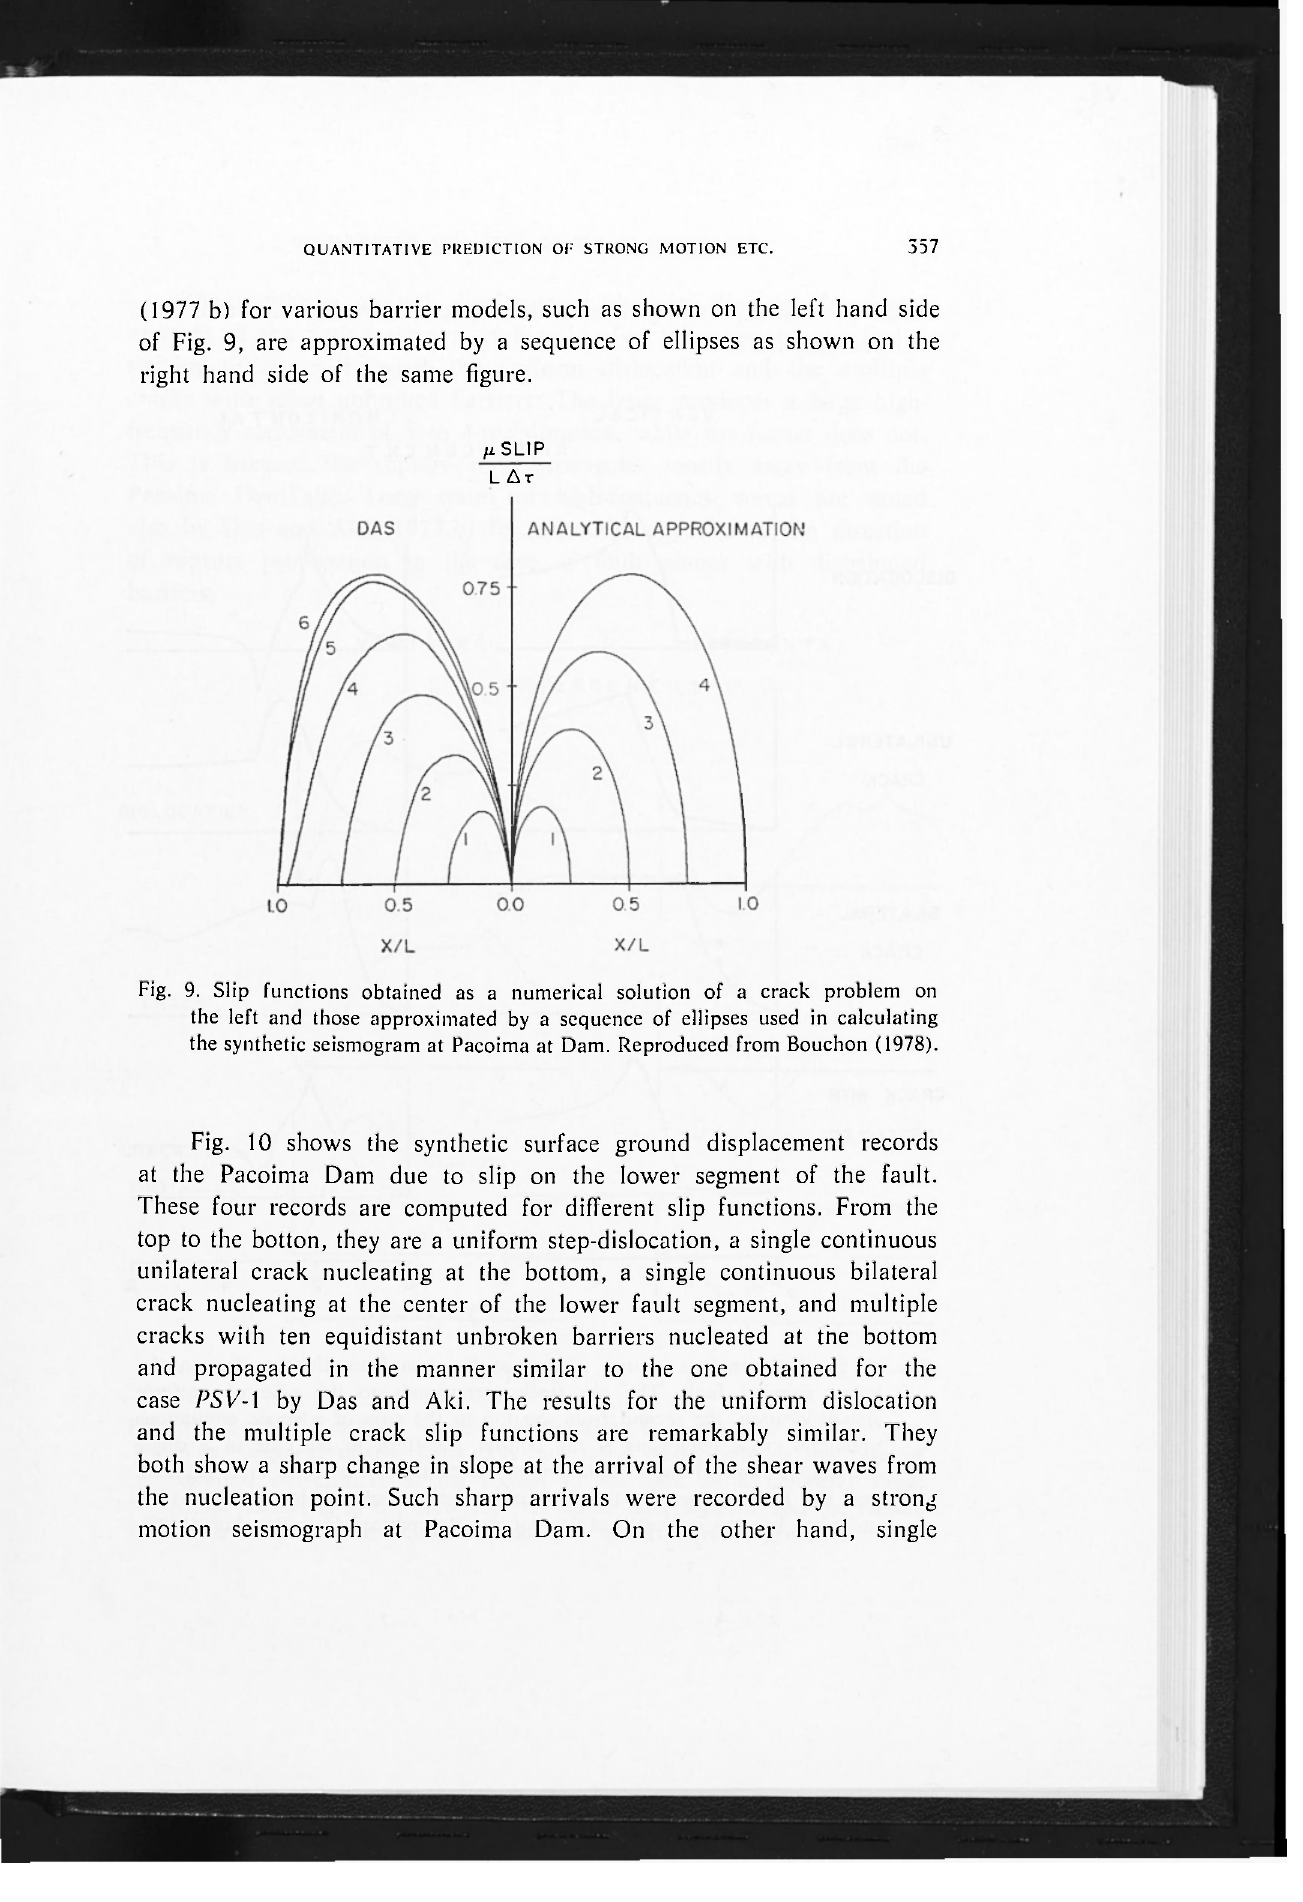
Fig. 9. Slip functions obtained as a numerical solution of a crack problem on the left and those approximated by a sequence of ellipses used in calculating the synthetic seismogram at Pacoima at Dam. Reproduced from Bouchon (1978).